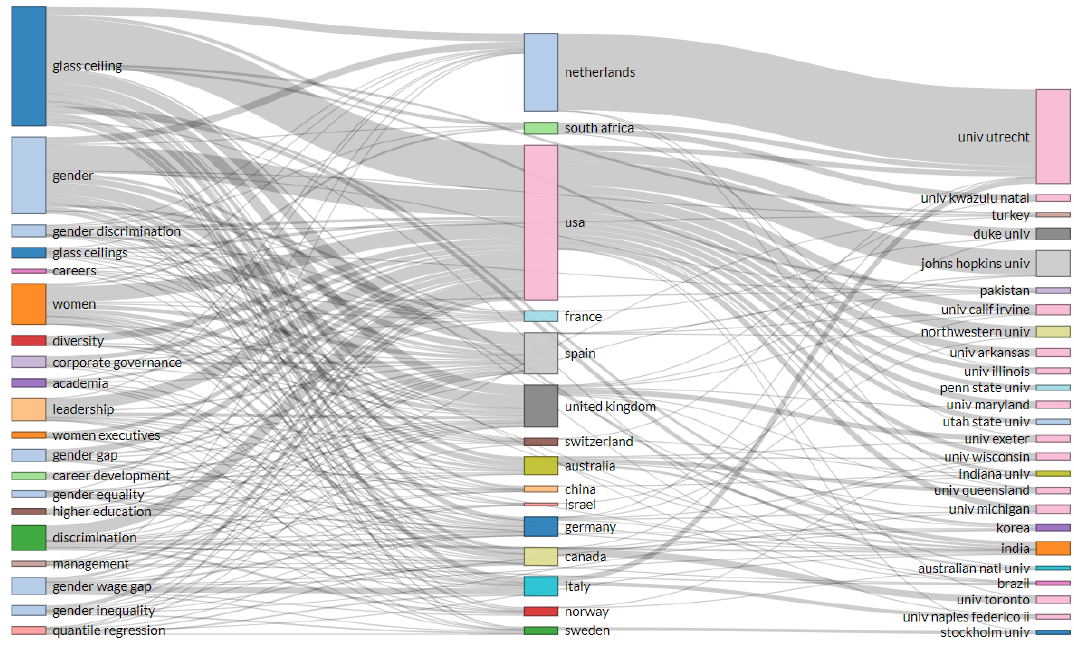
Figure 3. Three-fold analysis of glass ceiling literature.